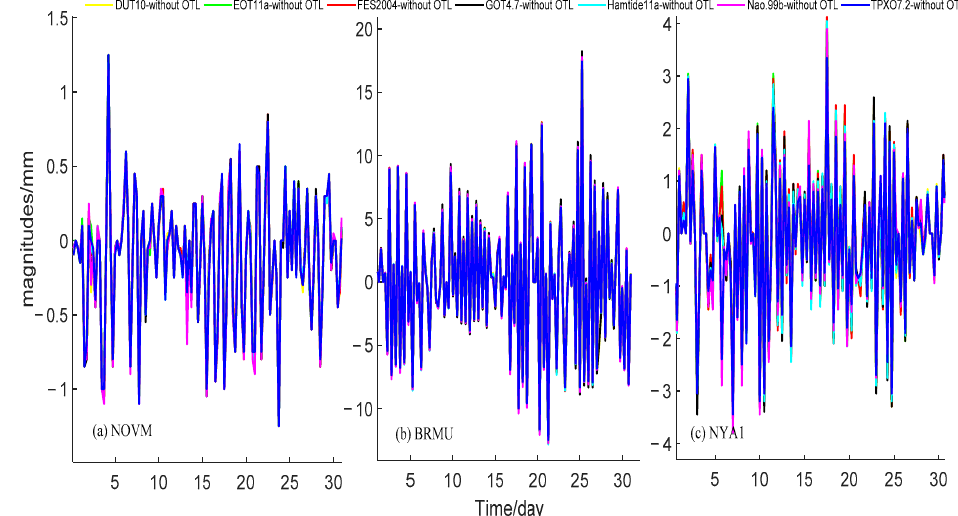
Figure 9. The difference of the ZTD calculated with inclusion or exclusion of the OTL models at the ( a ) NOVM station, ( b ) BRMU station, and ( c ) NYA1 station.